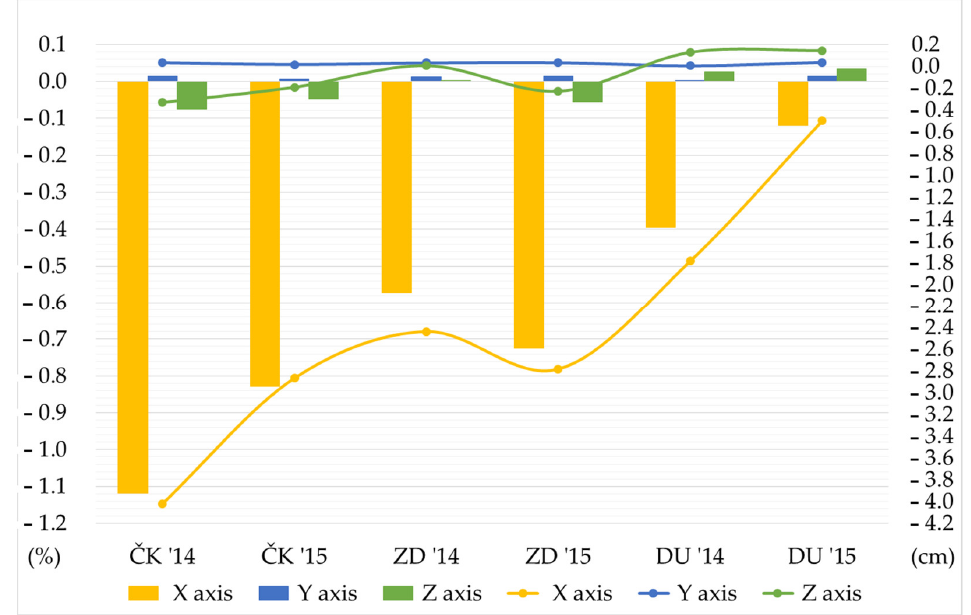
Figure 4. Movement of the parameter STD using the proposed model of observed locations expressed in absolute (right y -axis) and relative (left y -axis) values.